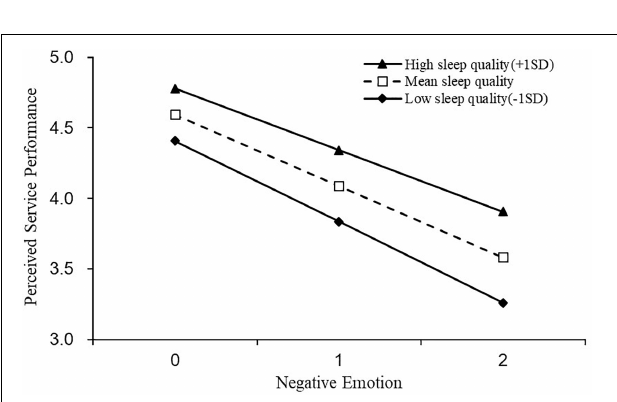
FIGURE 4 | The moderating effect of sleep quality on the relationship between positive emotions and perceived service performance.